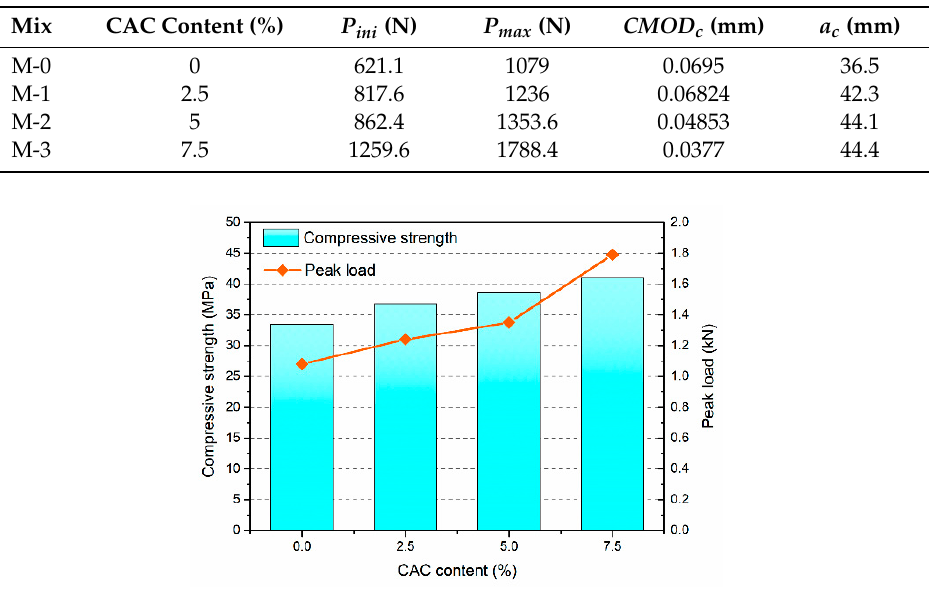
Figure 8. Peak loads of FAGC with different CAC contents.